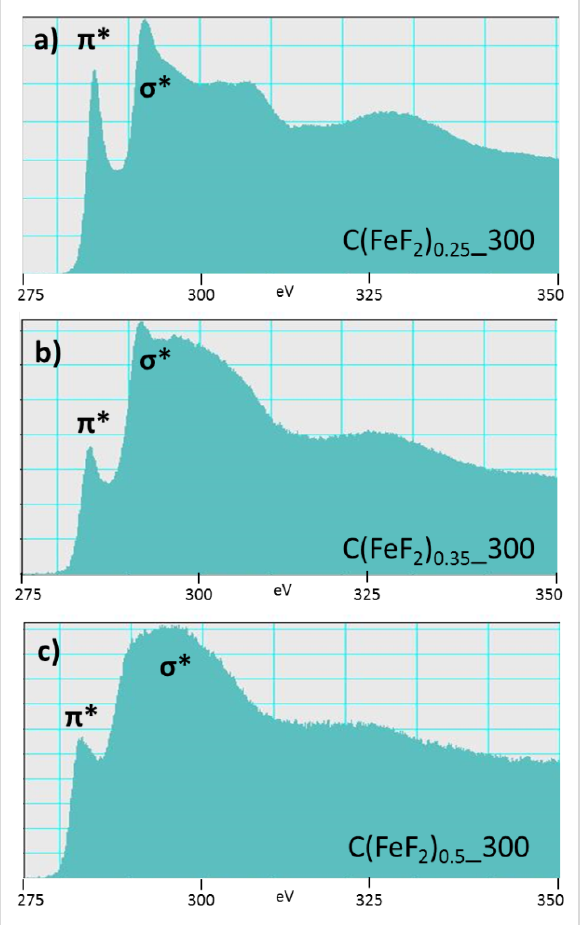
Figure 4: C K-edge EEL spectra of compounds with different carbon contents.